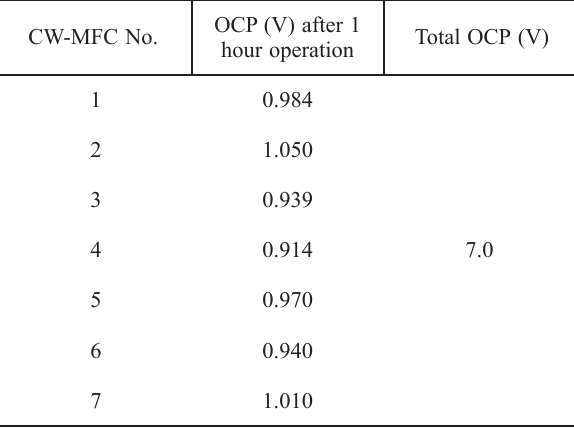
Table 1 – Open circuit potential (OCP) of 7 CW-MFCs and total OCP in series connection CW-MFC